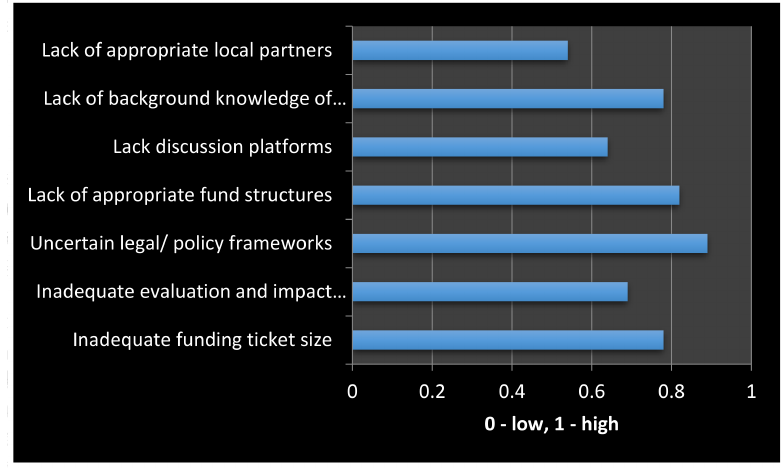
Figure 1. Barriers to mini-grid development. Source: